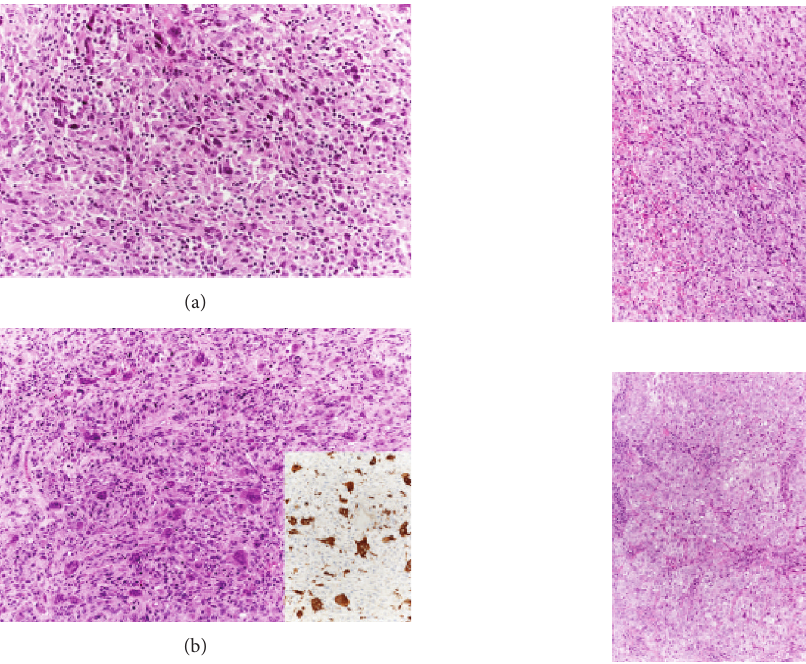
Figure 4: Neoplastic giant cells are characterized by deep pleo- morphism, with bizarre multiple hyperchromatic nuclei (a). They differ from reactive osteoclast-like giant cells (b) that show bland cytological features and are typically immunoreactive for CD68-KP1 (inset).